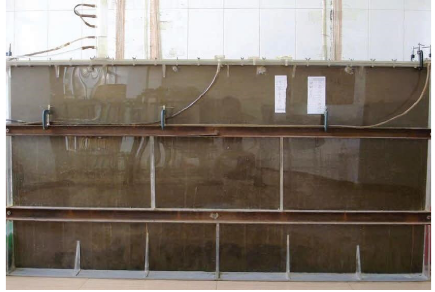
Figure 4: Photos of the experimental